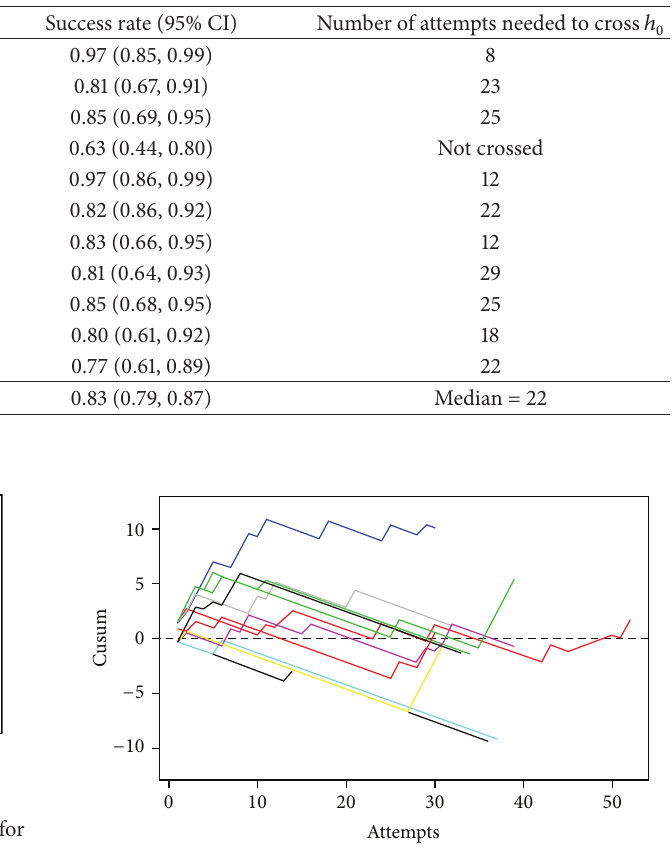
Figure 3: Risk-adjusted cusum chart for orotracheal intubation. Each color line represents the learning curves of each nurse anesthetist